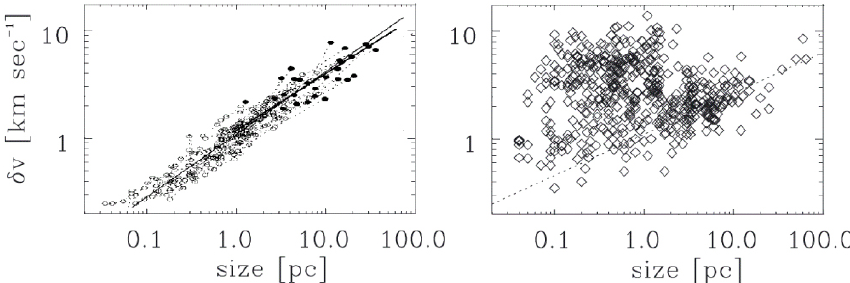
Fig. 4. Velocity dispersion relations from different surveys by Heyer and Brunt (2004) (left panel) and compilation from several surveys done by Ballesteros-Paredes et al. (2011) (right panel). As the later authors point out, while large CO clouds from the survey by Heyer et al. (2009) exhibit the typical Larson relationship, denser structures show a larger dispersion of velocity. This fact has been interpreted by those authors as being due to gravity in collapsing cores, while Falceta-Gonçalves et al. (2010b) argued for projection effects and